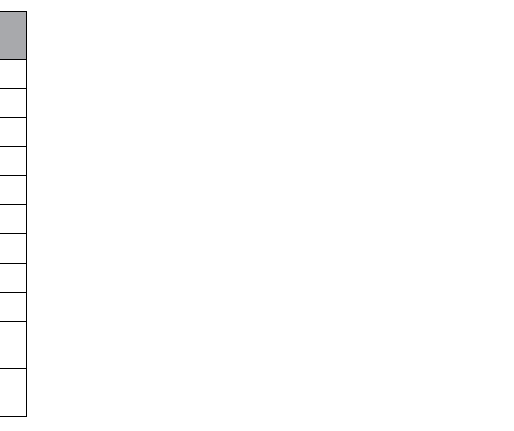
Table 3. Stability and M values for all data pooled.